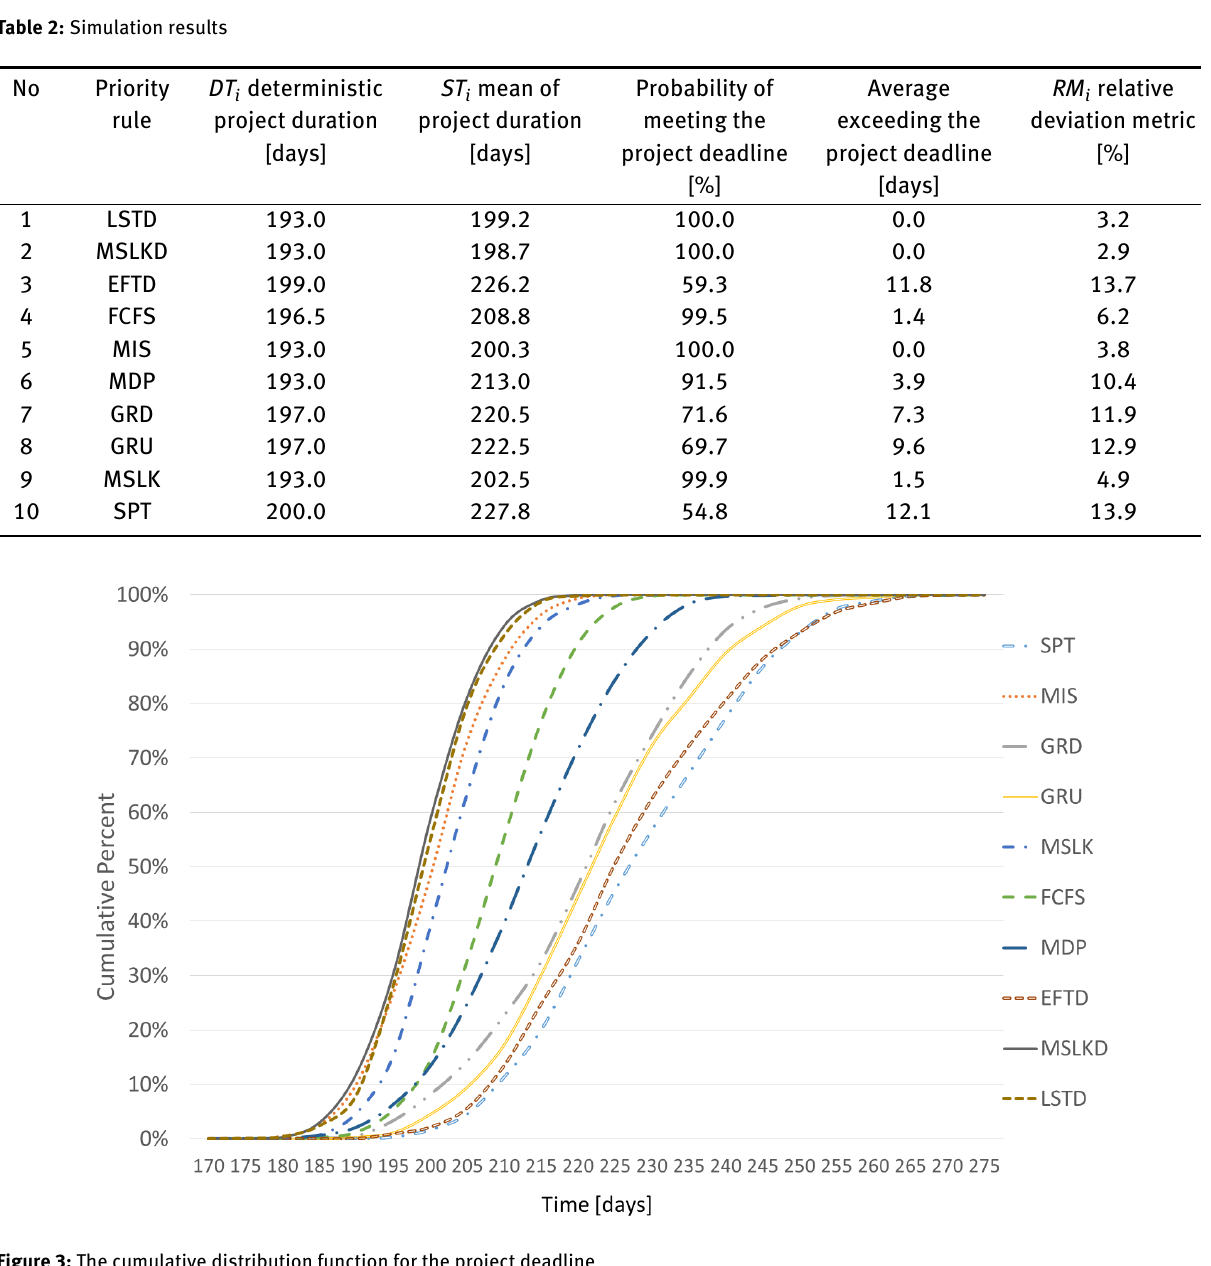
Figure 3: The cumulative distribution function for the project deadline